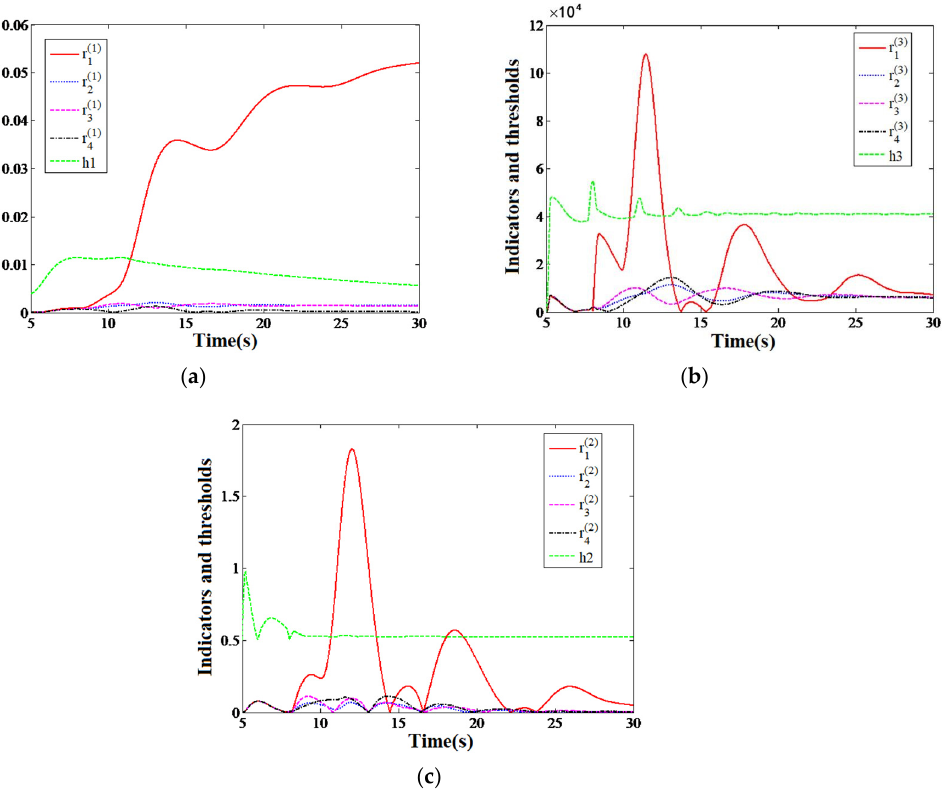
Figure 7. Change of fault detection index under Fault 2: ( a ) Fault detection index r i (1) and threshold h1; ( b ) Fault detection index r i (2) and threshold h2; ( c ) Fault detection index r i (3) and threshold h3.